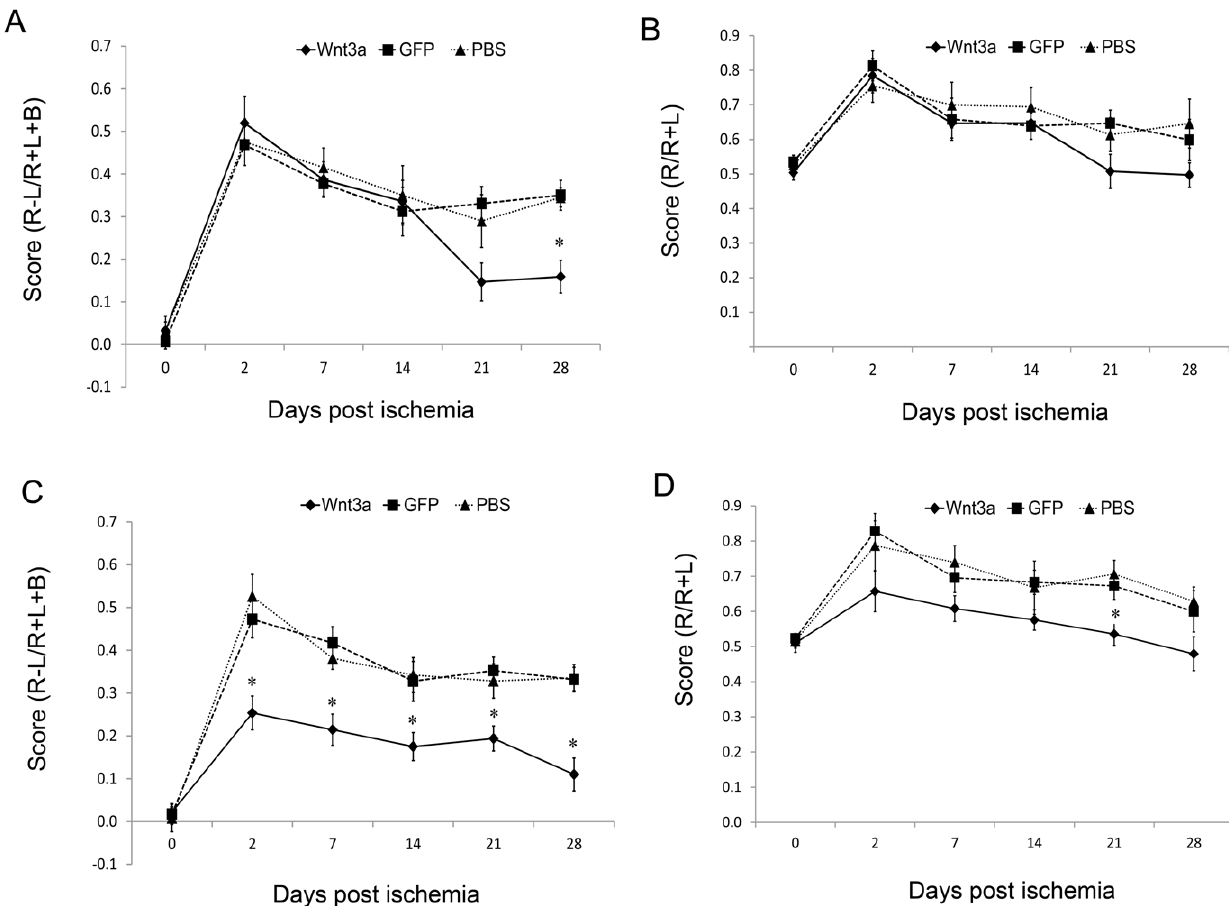
Figure 3. Effect of LV-Wnt3a-HA treatment on functional recovery. A–B. LV-Wnt3a-HA injection into the striatum significantly improved functional performance at 28 days after injury on the cylinder test (A; p , 0.05) but not on the corner test (B). C–D. LV-Wnt3a-HA treatment into the SVZ significantly improved functional recovery from day 2 after injury on the cylinder test (C; p , 0.05) and on day 21 after injury on the corner test (D; p , 0.05). Data are given as mean 6